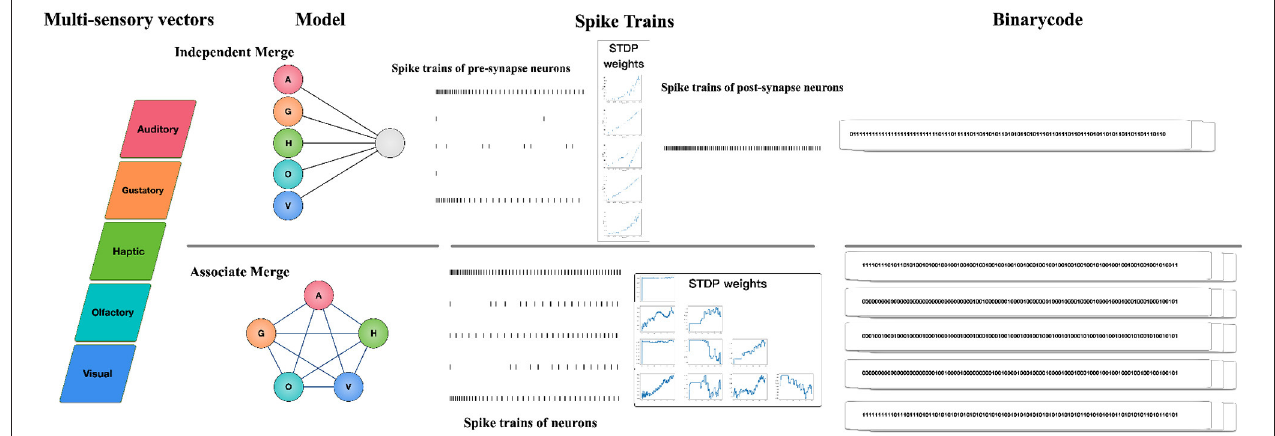
FIGURE 2 | The framework of multisensory concept learning framework based on spiking neural networks. Firstly, for each modality of the concept, we employ a neural model and transform its perceptual strength in the concept’s multisensory vector into external stimuli to the neuron; Secondly, the architecture of SNN is designed according to different assumptions. We choose the IM paradigm if we assume that multiple senses are independent of each other before fusion, and we choose the AM paradigm if we assume that multiple senses are associated with each other; Thirdly, we specify the neuron model in SNN and sequentially feed concepts to the network, with STDP rules adjusting the network’s connection weights. Given the running interval [0, T ], we record the spike trains of each neuron; Finally, we convert the spike trains of specific neurons into binarycode as the final integrated